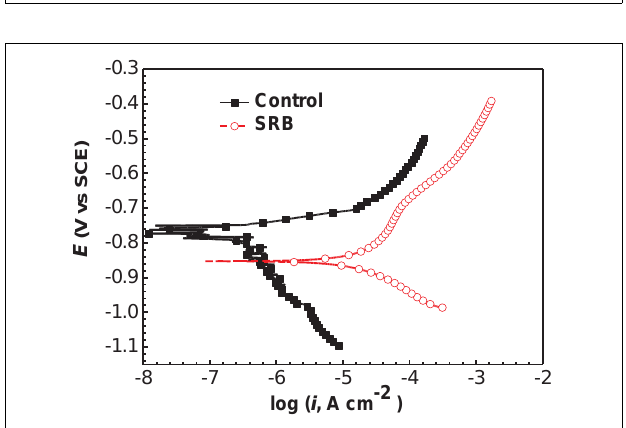
FIGURE 11 | Potentiodynamic polarization curves of specimens covered with deposit in the absence and presence of SRB after 14 days of incubation in CO 2 -saturated simulated formation water.